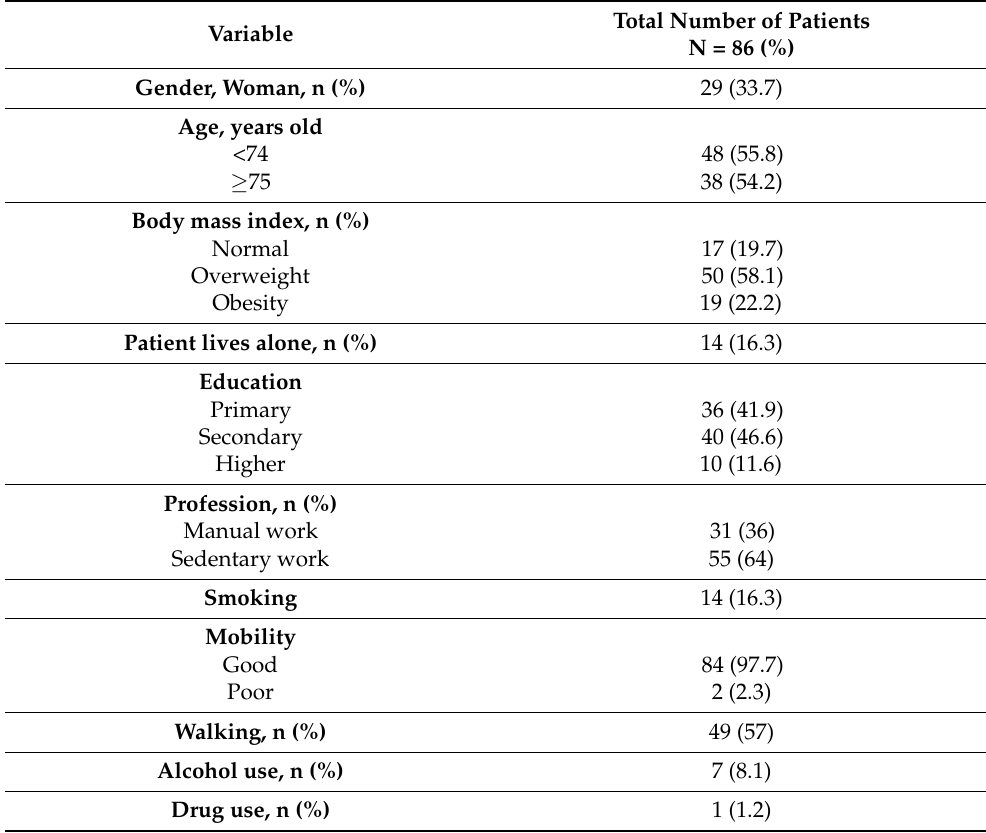
Table 1. Demographic characteristics of patients. Number = N or